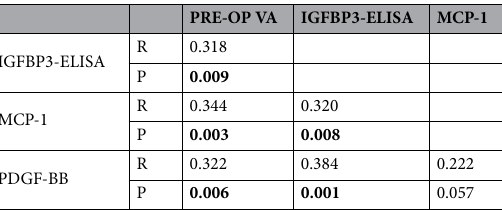
Table 3. Correlations between protein levels and visual acuity. Spearman’s correlation coefficents (R) and P values ( P ) are given. Significant differences ( P < 0.01) are indicated in